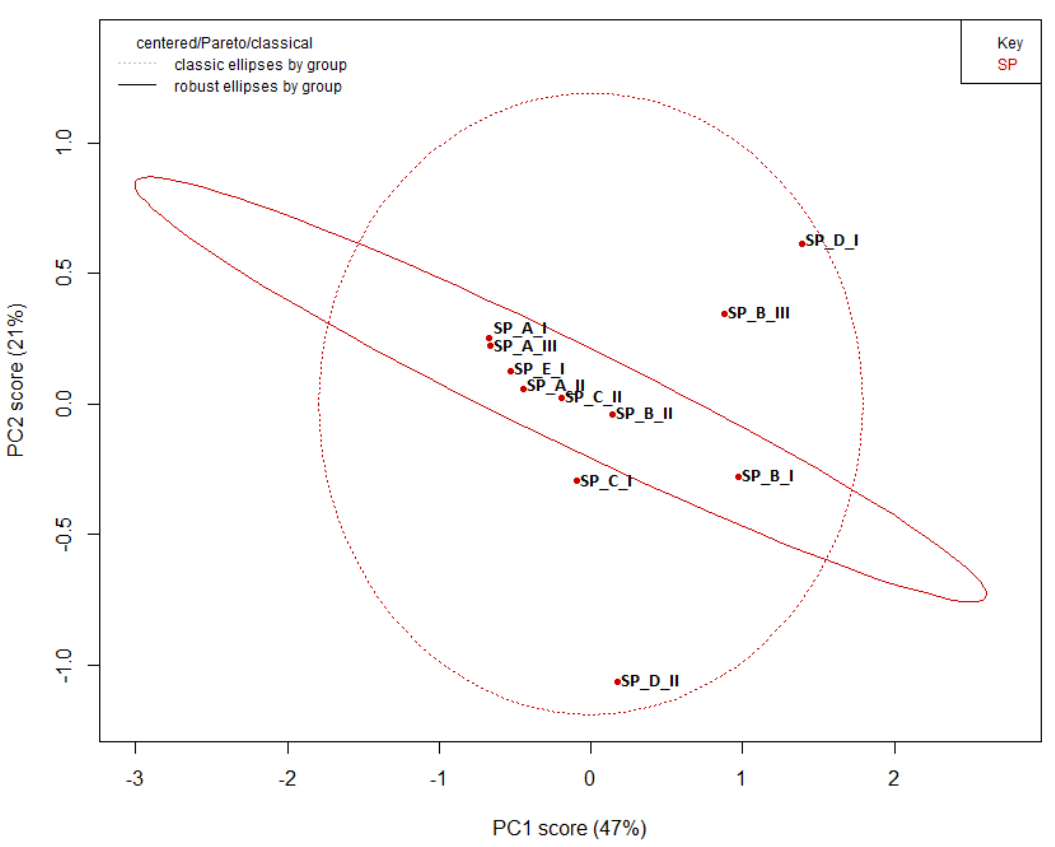
Figure 3. A PCA plot of the chromatographic data, where the SP prefix denotes “sample”’ followed by the label.